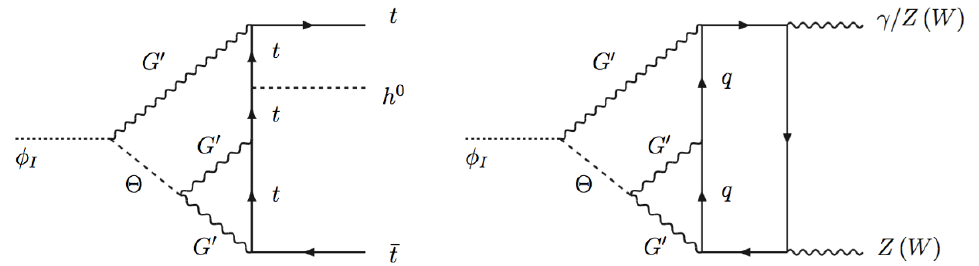
< M (cid:2) . Left diagram: (cid:30) I I